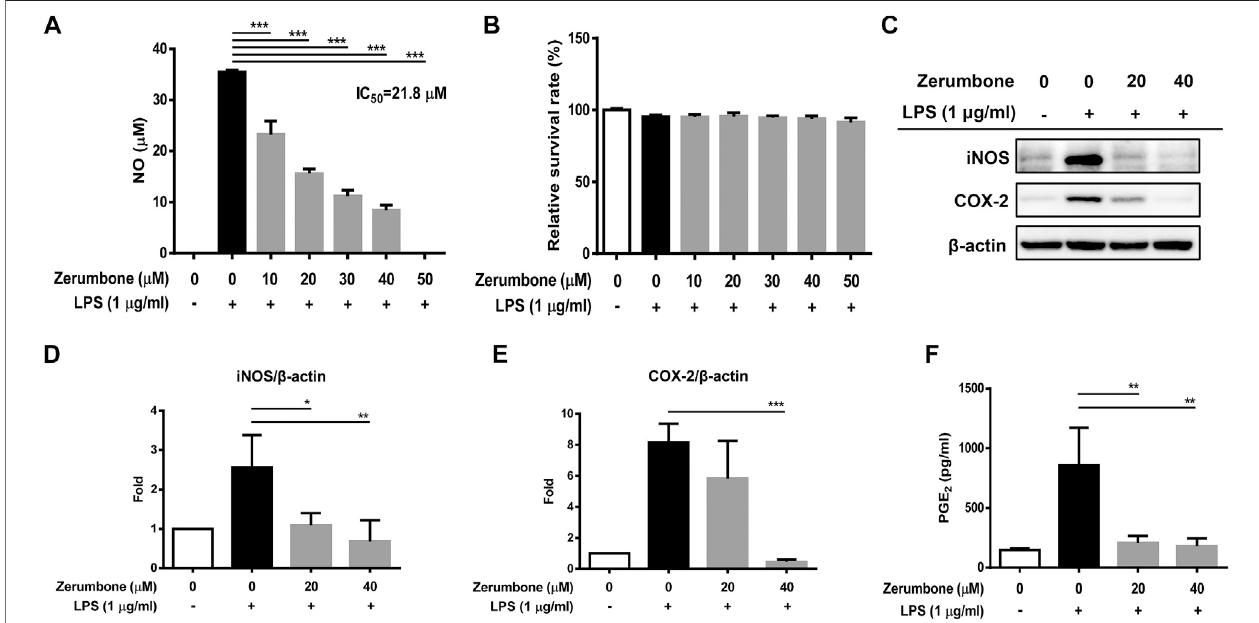
FIGURE1| TheeffectsofzerumboneontheNOproduction,cellviability,andiNOSandCOX-2expressionsinLPS-activatedJ774A.1cells.Cellswerepre-treated with various doses of zerumbone for 1 h following treatment of LPS (1 μ g/ml) for 24 h. (A) The cell culture supernatant was collected and the production of NO was determined by Griess reagent assay. (B) Cell viability was analyzed by MTT assay. (C) Cells were harvested and lyzed by lysis buffer, and the expressions of iNOS and COX-2 were determined using Western blot. β -actin was regarded as a loading control. The representative Western blot results were obtained in three separate experiments. (D – E) Theintensitiesofbandswerequanti fi edfromthreeseparateexperimentsandnormalizedtountreatedsamples. (F) Cellsupernatantswerecollected and the levels of PGE 2 were measured by ELISA. Data were represented as means ± SD. Statistical signi fi cance between the zerumbone-treated groups vs. the LPS- only group is represented as follows: * p < 0.05, ** p < 0.01 and *** p <